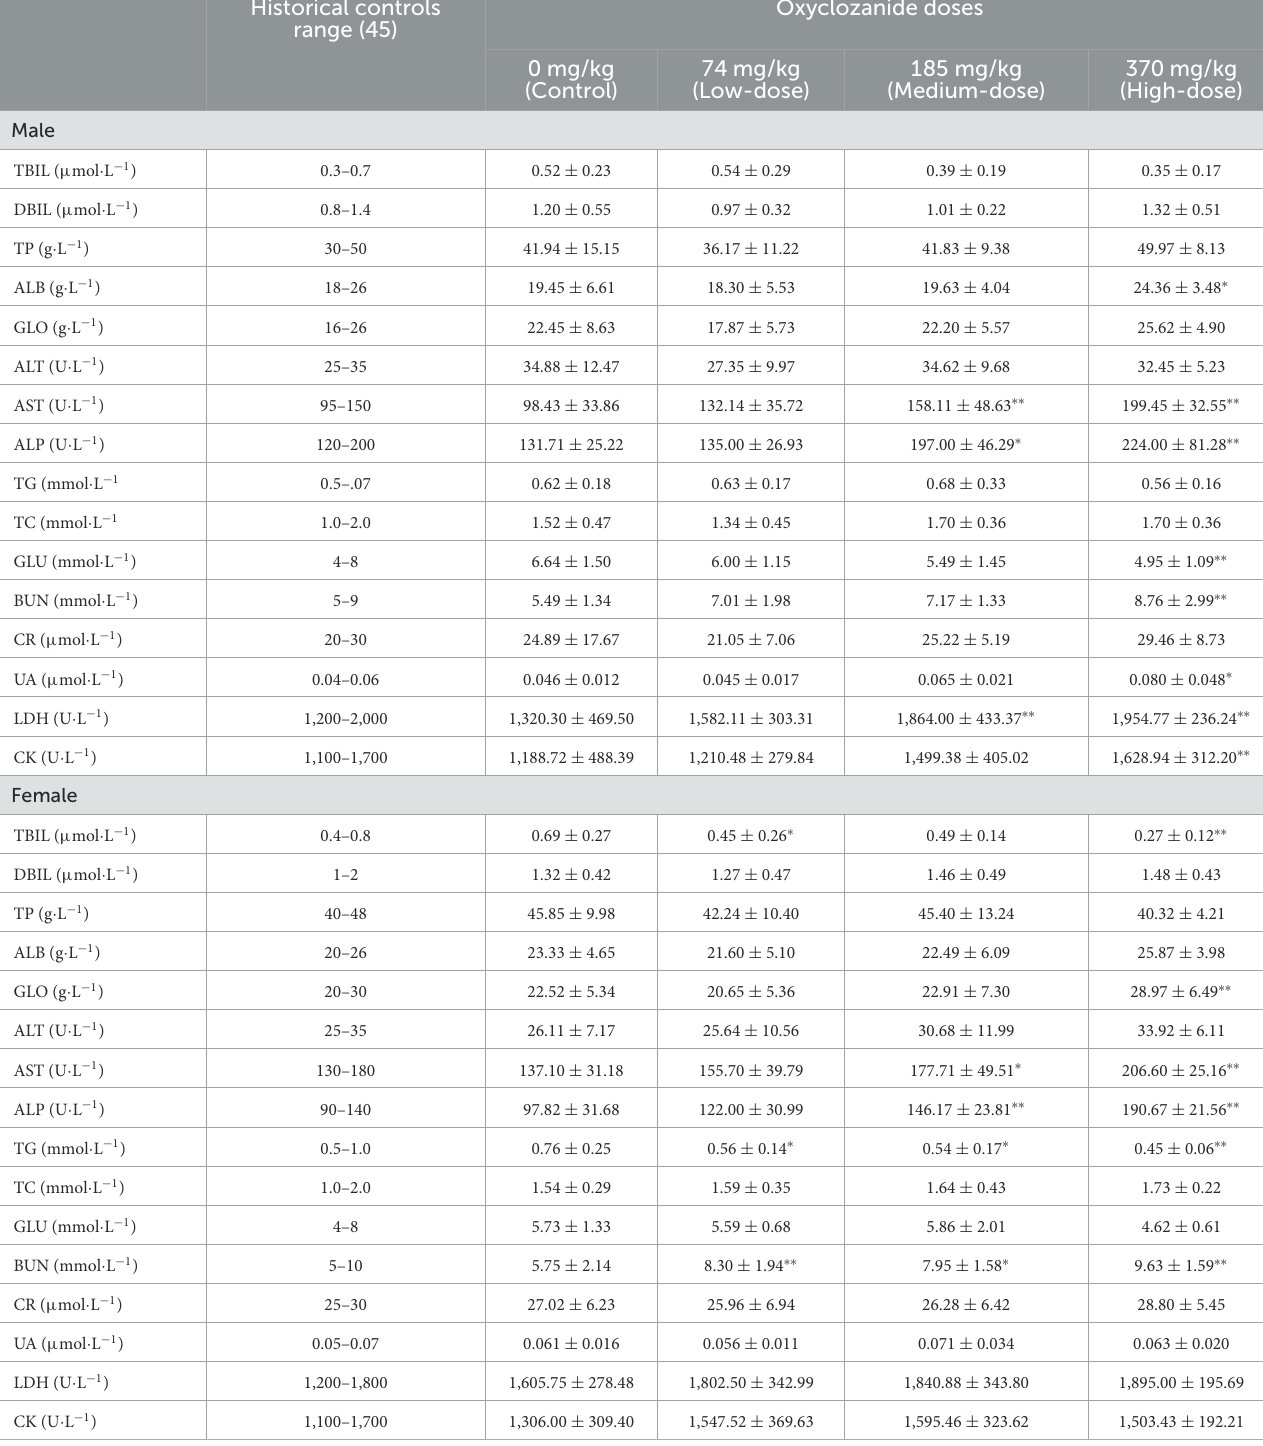
TABLE 3 Liver function related to biochemical